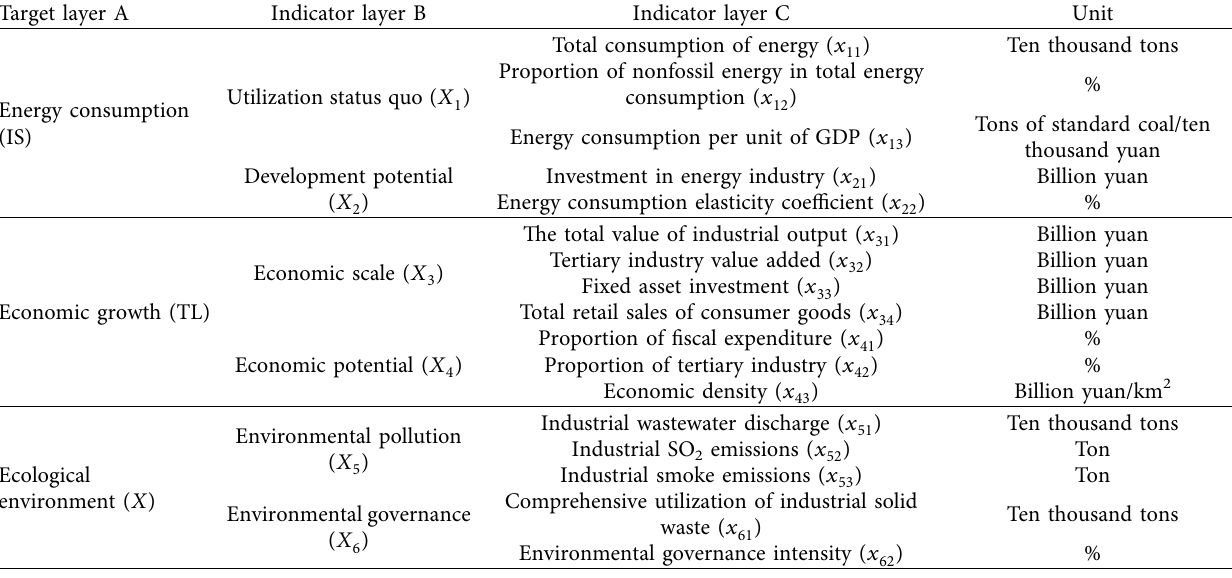
Table 1: China’s energy consumption, economic growth, and ecological environment measurement index system.